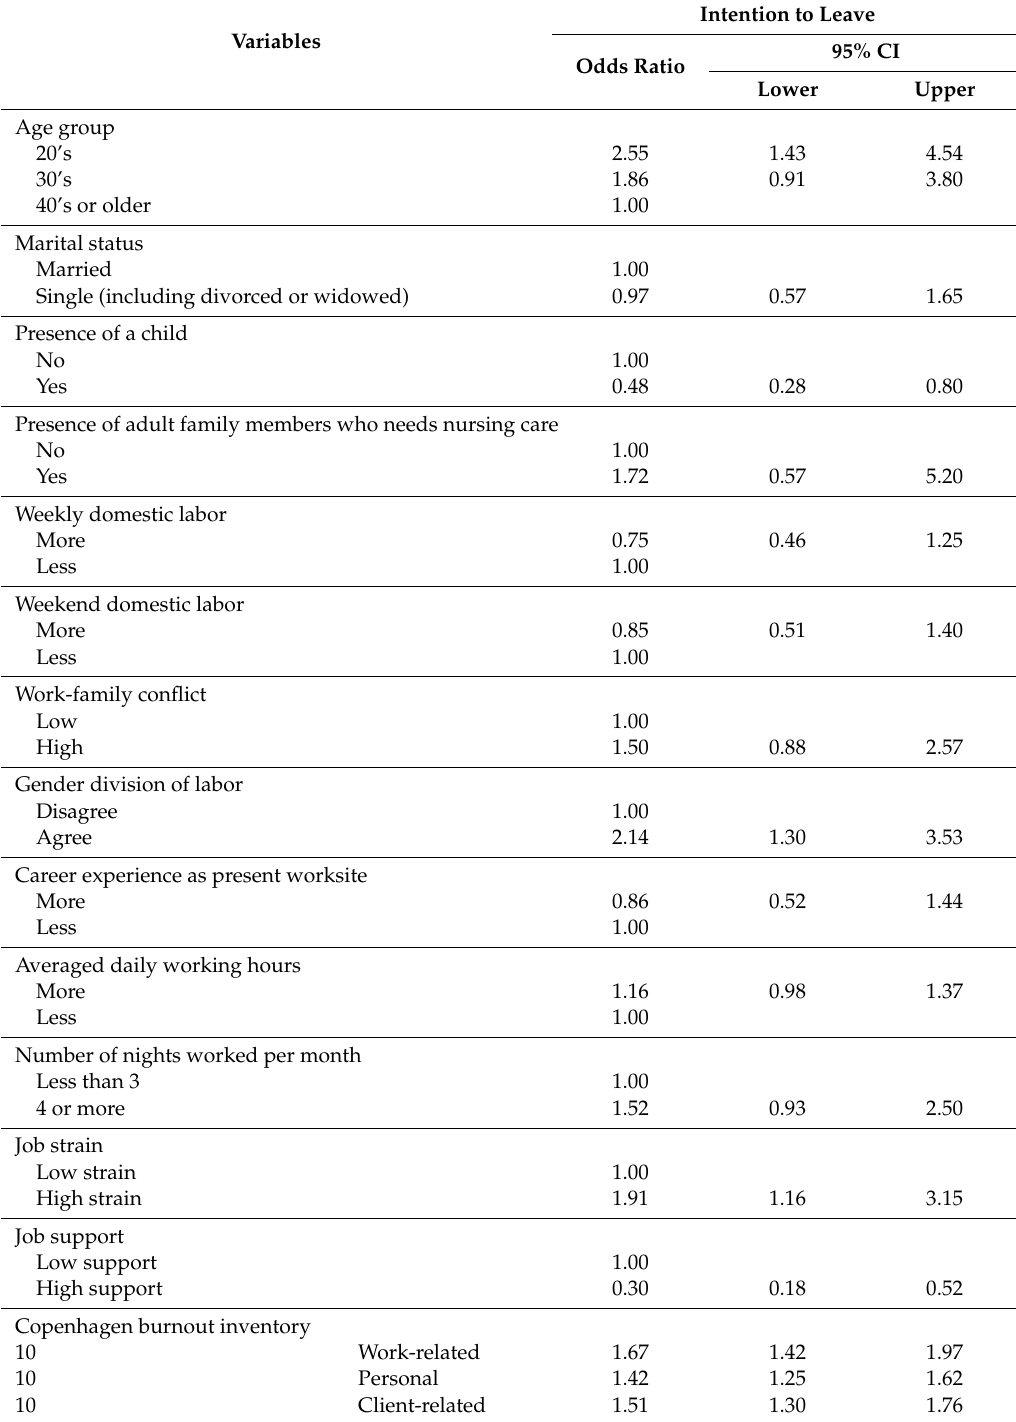
Table 3. Factors associated with “intention to leave”—univariate logistic regression model. Variables